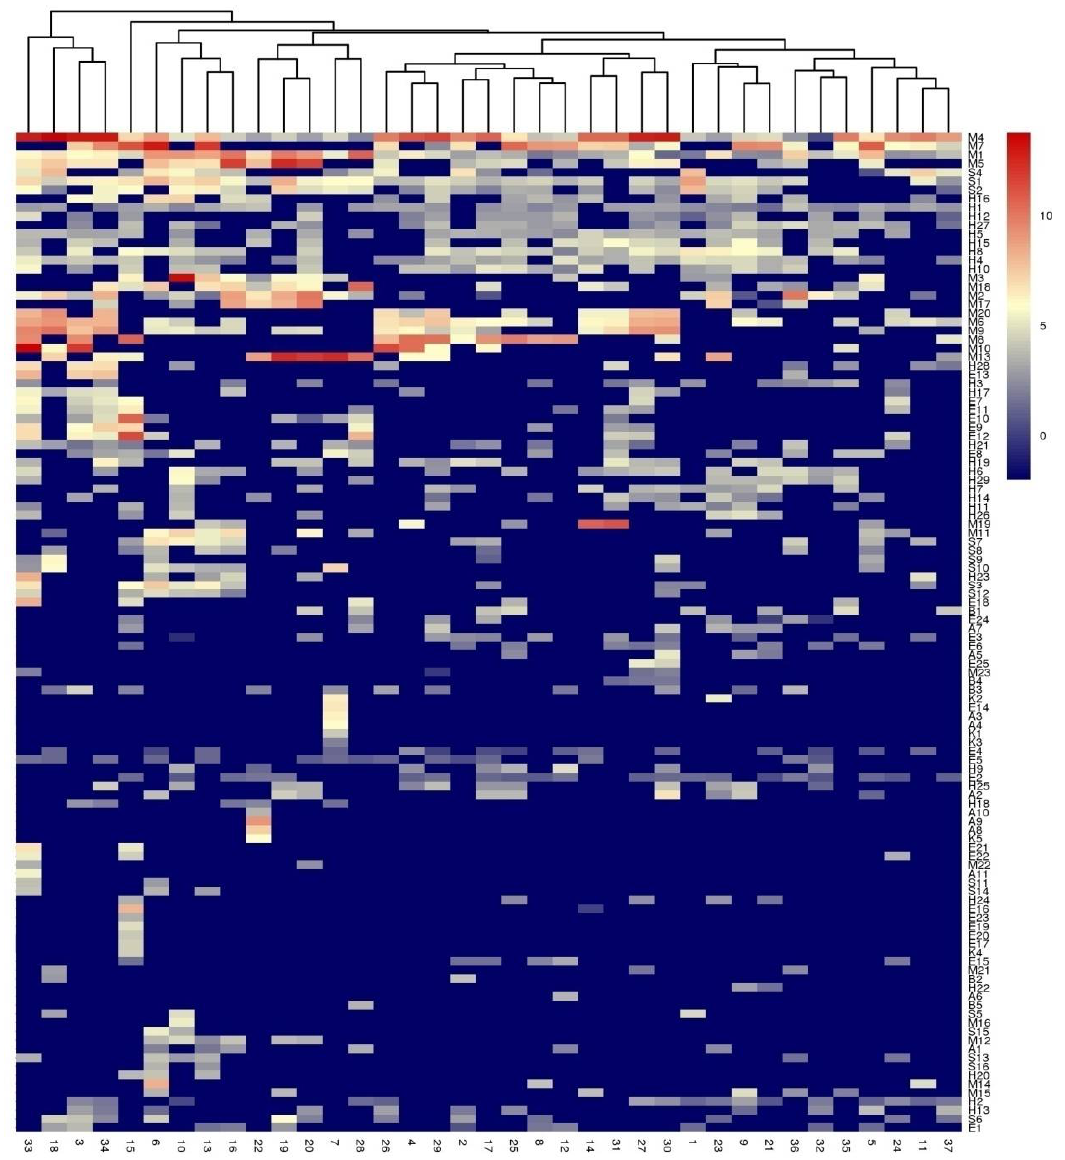
Figure 3. Hierarchical clustering (HCA) and heatmap of volatile compounds levels in 37 mango cultivars. values of all studied volatile compounds per cultivar are shown in the heatmap on a blue (negative) to red (positive) scale. The HCA and dendrogram of cultivars was according to Euclidean distance.